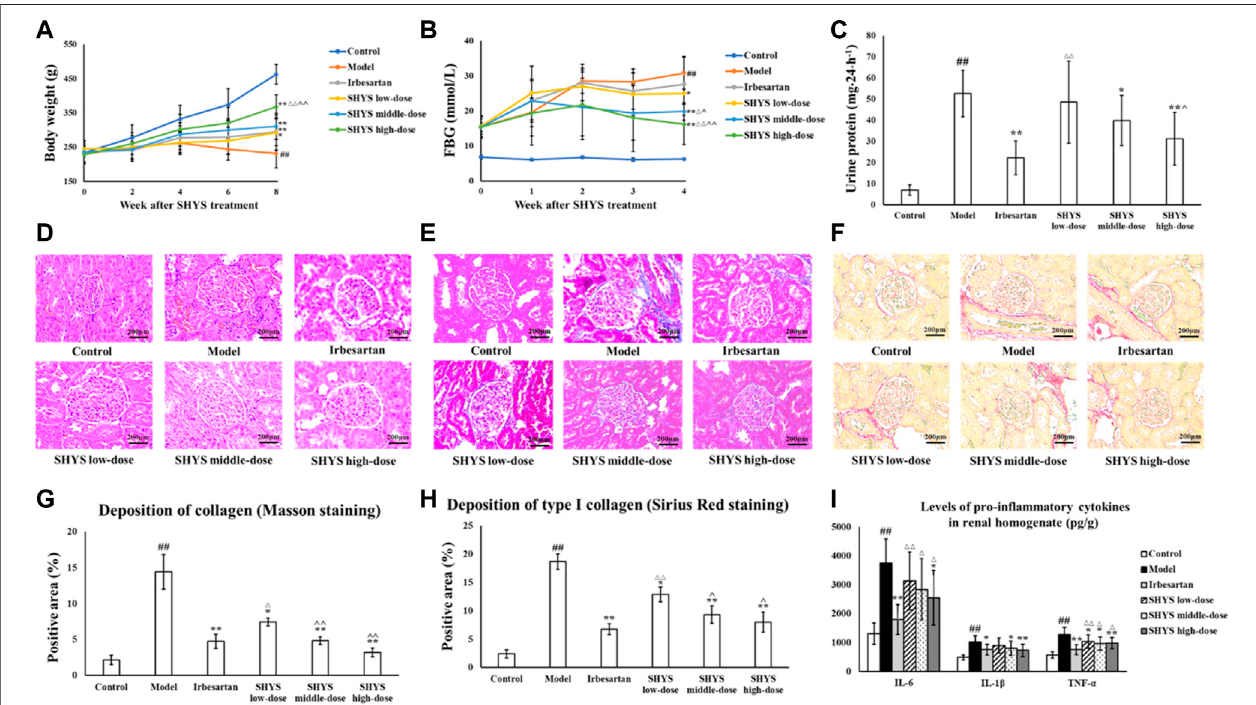
FIGURE2| SHYStreatmentalleviated thebodyweight loss,hyperglycemia,proteinuria,pathologicalchangesinkidneyand in fl ammatory response inDNrats. (A) SHYS treatment alleviated the body weight loss in DN model rats. (B) SHYS treatment decreased the FBG in DN rats. (C) SHYS treatment decreased the level of 24-h urine protein. (D) H and E staining indicated that SHYS treatment signi fi cantly improved the pathological changes of kidney in DN rats (200 × ) (E – H) Masson (E,G) and Sirius red (F,H) staining indicated that SHYS treatment signi fi cantly decreased collagen depositions in kidney (200 × ). (I) SHYS treatment decreased the levels of pro-in fl ammatory cytokines in renal tissue homogenates. Control, Model, Irbesartan, SHYS low-dose, SHYS middle-dose and SHYS high-dose ( n (cid:2) 10 per group) groups. Dataarepresented asthemean ± SD. ## : p < 0.01 ascompared tothe Control group; *: p < 0.05 ascompared totheModel group; **: p < 0.01ascomparedto the Model group; △ : p < 0.05 as compared to the Irbesartan group; △△ : p < 0.01 as compared to the Irbesartan group; ^ : p < 0.05 as compared to the SHYS low-dose group; ^^ : p < 0.01 as compared to the SHYS low-dose